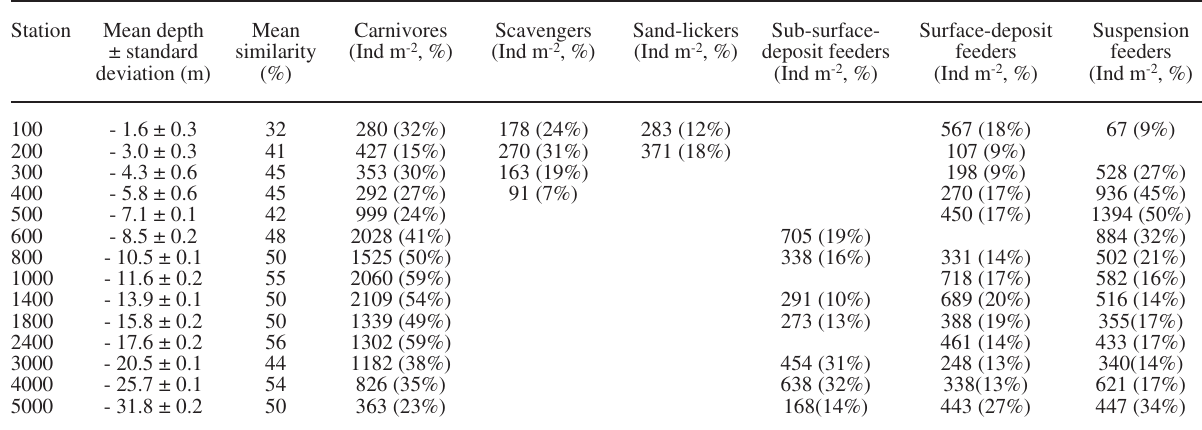
Table 3. – siMPer analysis applied to the feeding guild densities per sampling station (mean depth ± standard deviation), with indication of: the percentage of each station’s mean similarity; and density (ind m -2 ) and the percentage that each feeding guild (between brackets) contributed to the similarity of each sampling